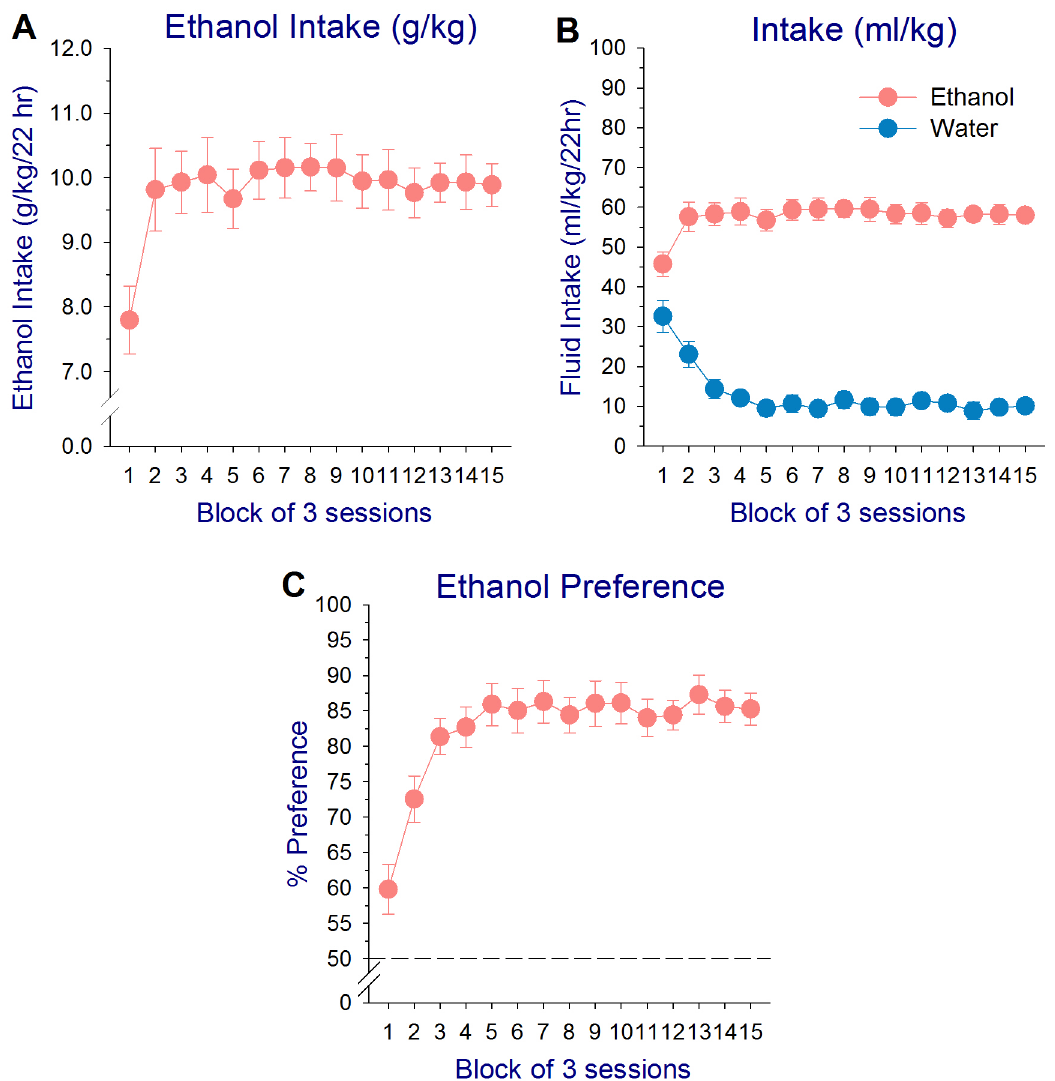
Fig 1. Mean ( ± SEM) g/kg ethanol intake (A), ml/kg ethanol and water intake (B), and ethanol preference (ratio of ethanol consumed to total fluid intake; C) in selectively bred alcohol-preferring (P) rats across all 15 session blocks of ethanol exposure (45 sessions total) in an intermittent- access 20% ethanol drinking paradigm. Individual session data were averaged in 3-session blocks prior to